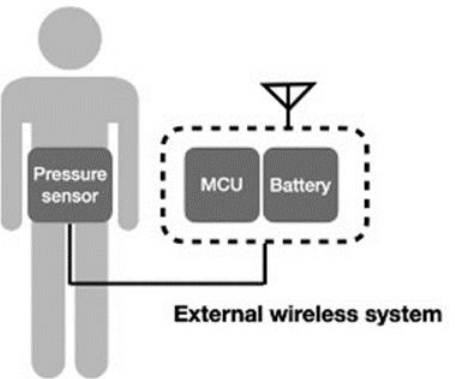
Figure 7. Schematic of external wireless intra-abdominal pressure-monitoring sensor system.